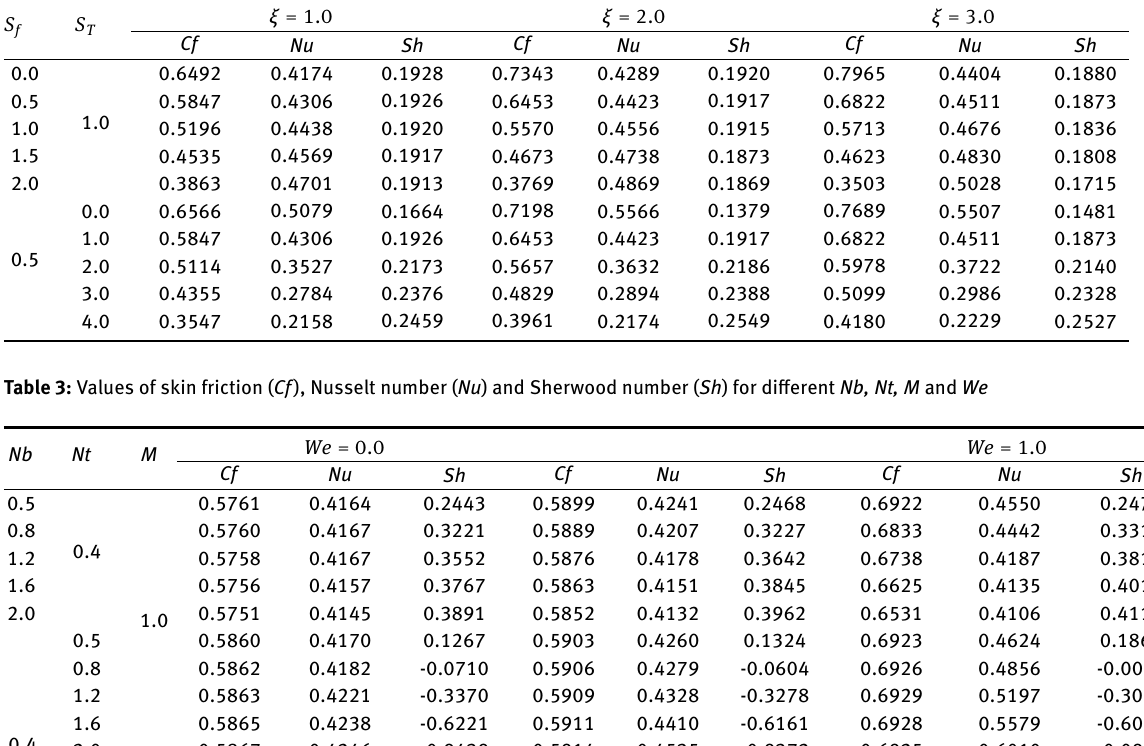
Table 2: Values of skin friction ( Cf ), Nusselt number ( Nu ) and Sherwood number ( Sh ) for different S f , S T and ξ